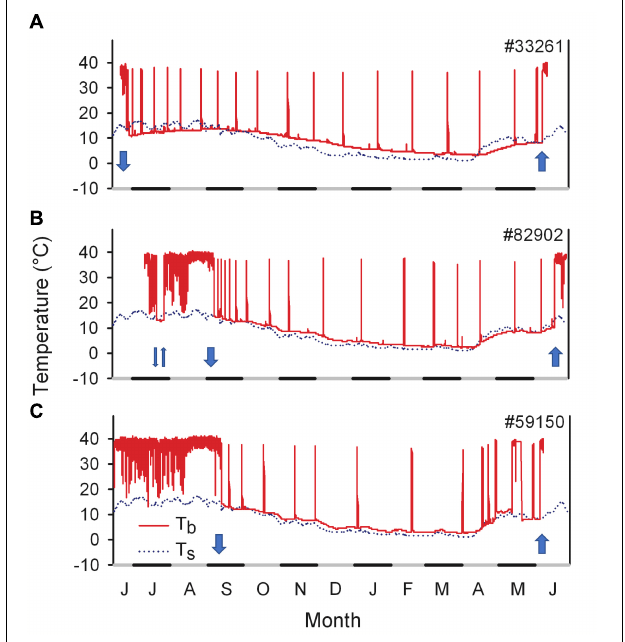
FIGURE 4 | Year-round records of core body temperature ( T b , solid lines) in three free-living edible dormice in 2012/2013. (A) Example of an animal showing an early onset of hibernation in June and staying in hibernation for 331 days. (B) An animal using multiday torpor during the active season in July. (C) An individual showing a long active season, entering hibernation in September. Torpor T b during hibernation and summer dormancy was close to soil temperature ( T s , dotted lines). The arrows indicate retreat into (arrow down) and emergence from (arrow up) underground hibernacula. Modified from Hoelzl et al.